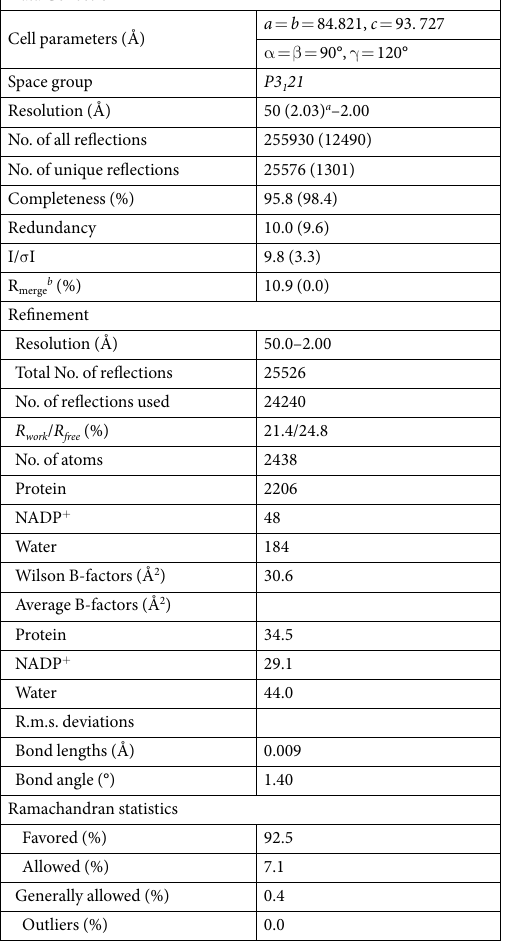
Table 1. X-ray diffraction data and structure refinement statistics. a Values in parentheses are for the highest